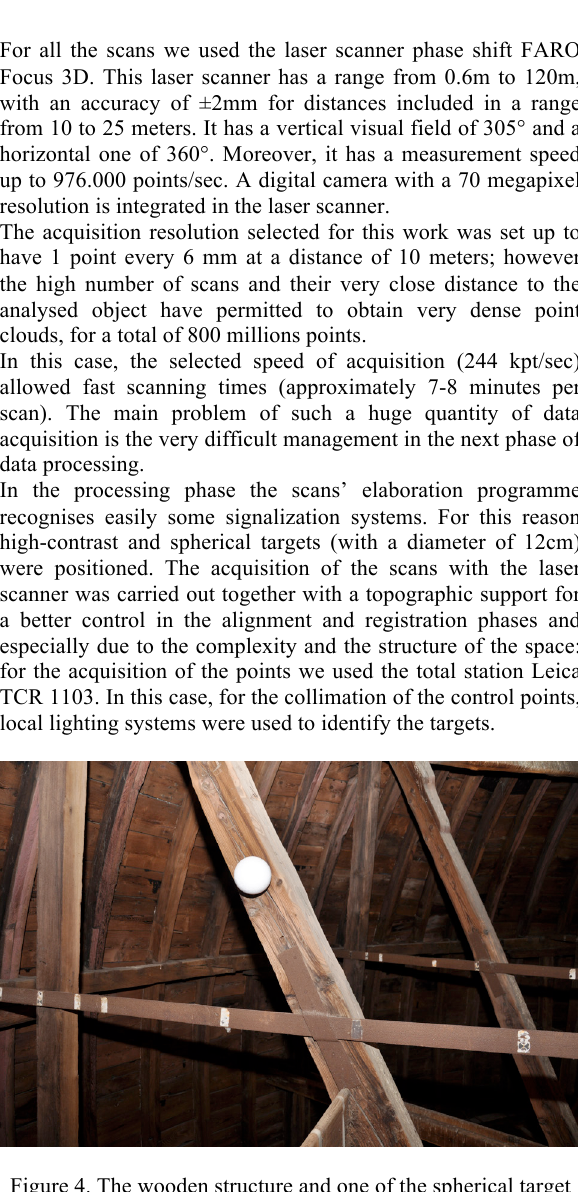
Figure 6. On the left the sectioned point-cloud; on the right the entire point-cloud inclusive of the 20 scans at the 4 different levels.